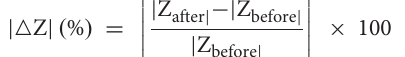
Frontiers in Aging Neuroscience |